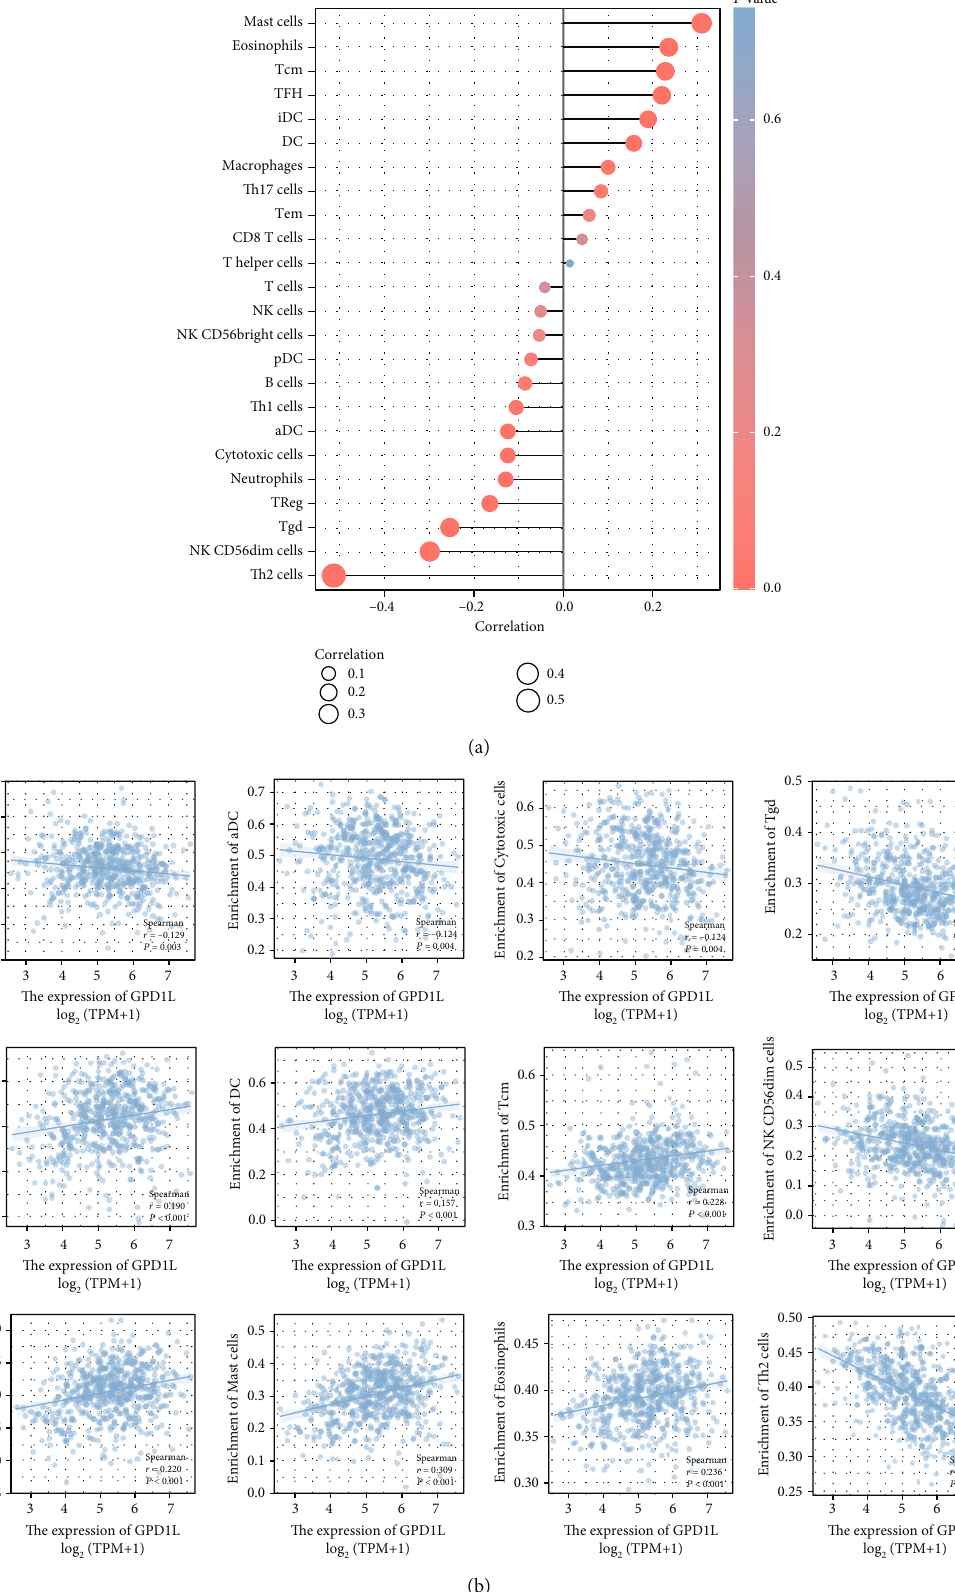
Figure 8: (a, b) Relationships between GPD1L and in fi ltrating immune cells in